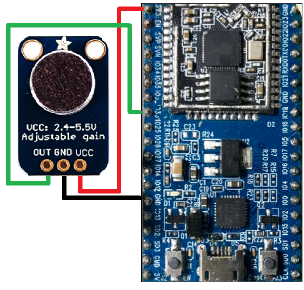
Figure 4. Wireless acoustic sensor based on ESP32 board.